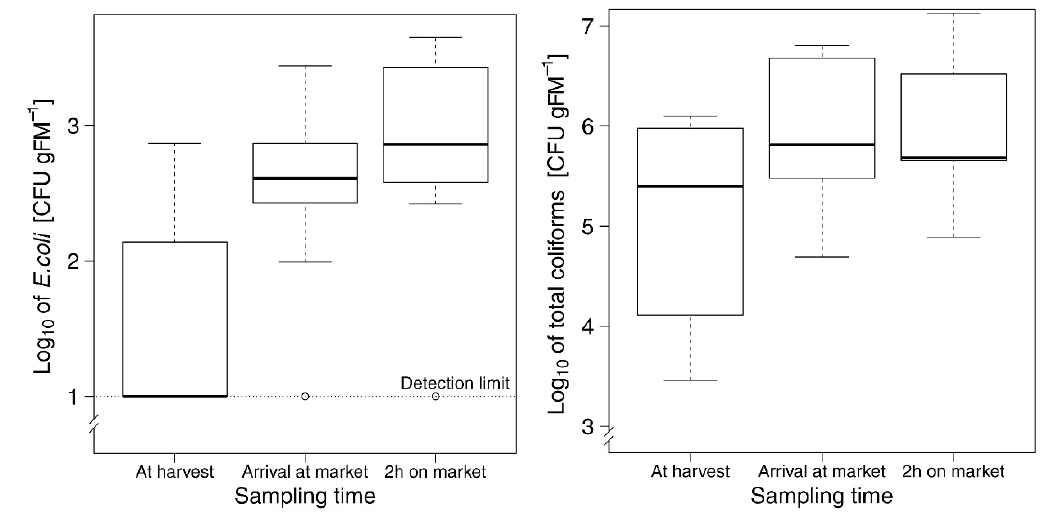
Figure 2. Load of E. coli (left) and total coliforms (right) on lettuce at the time of harvest, arrival at the market, and two hours after arrival in the market in Ouagadougou (Burkina Faso), 2014. Boxplots show the lower quartile, and median and upper quartile, with whiskers extending to the most extreme data point that is no more than 1.5 times the interquartile range from the edge of the box. Table 3. Results from the glmmPQL model that was used to test for influencing factors on the contamination of lettuce by Escherichia coli and total coliforms at different locations and different sampling times during a monitoring of 10 lettuce traders in Ouagadougou (Burkina Faso), 2014. Significant relations between the contamination degree of lettuce and an explanatory variable are highlighted in bold using p = 0.05 as the significance threshold.